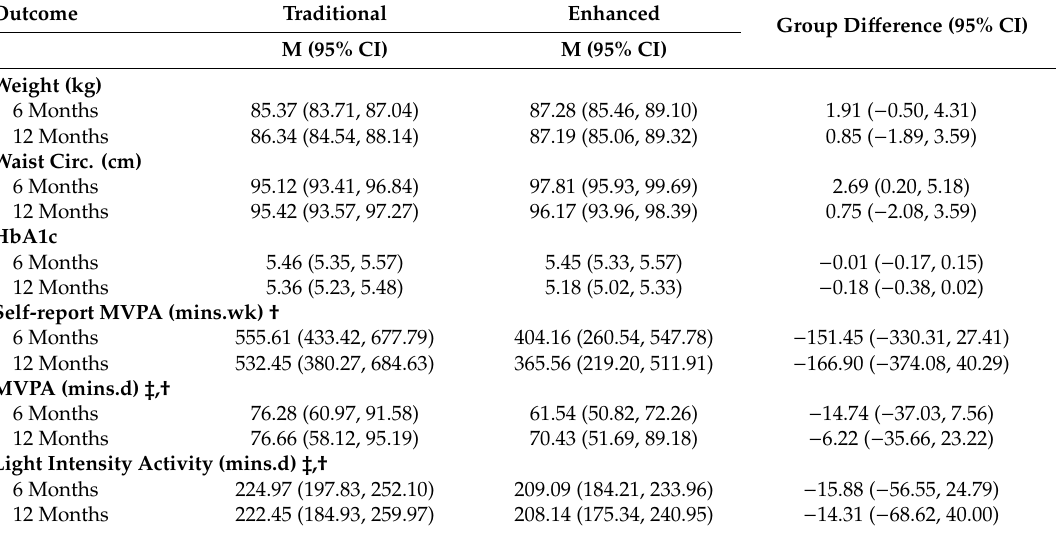
Table 3. Baseline adjusted group di ff erences between Enhanced and Traditional groups at 6 months and 12